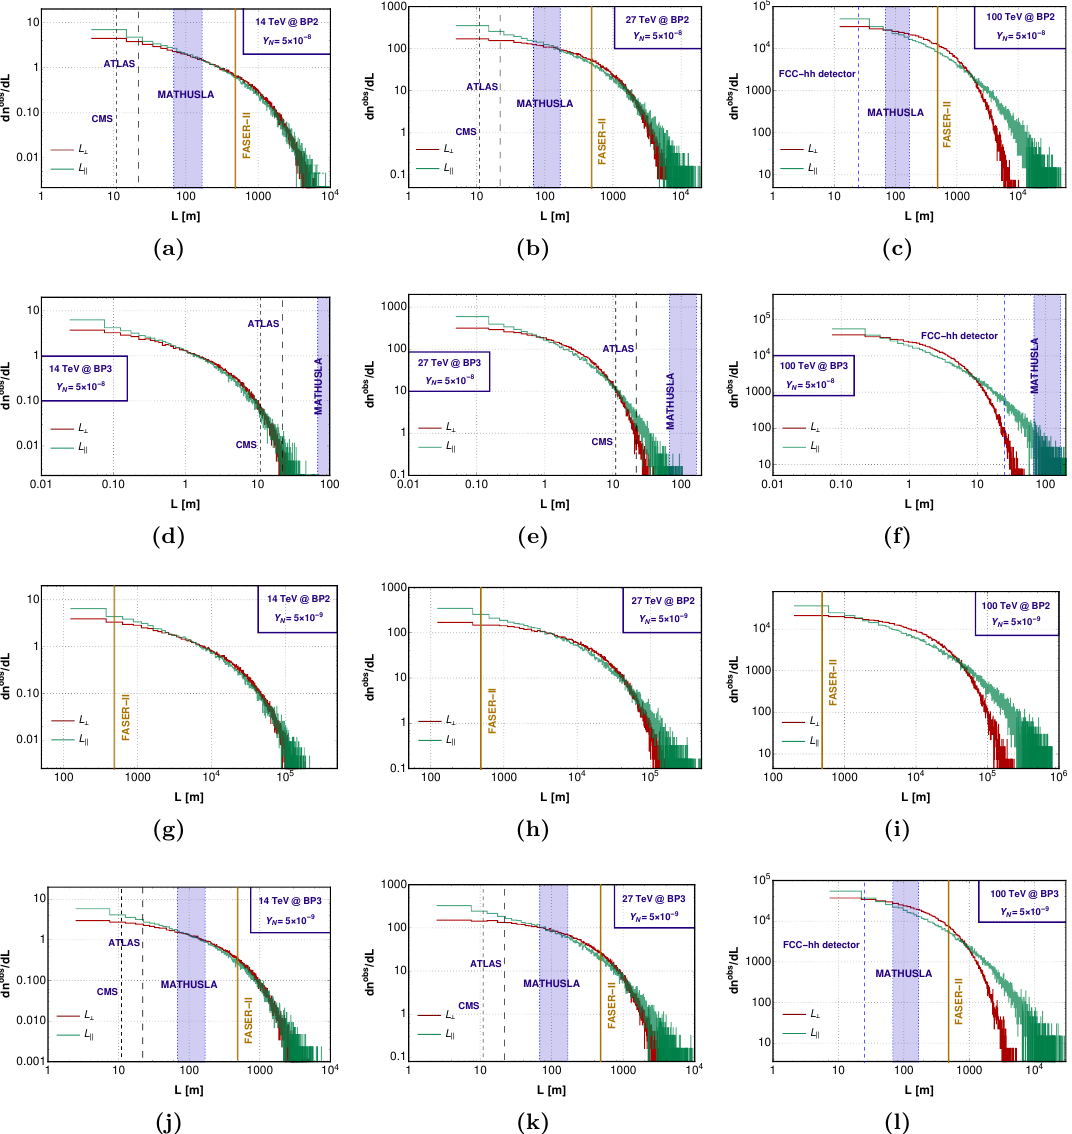
in green) decay length Figure 11. Displaced transverse ( L ⊥ in red) and longitudinal ( L || distributions for N , coming from the pair productions at the LHC with the centre of mass energies of 14 TeV (a, d, g, j), 27 TeV (b, e, h, k) and 100 TeV (c, f, i, l) with the integrated luminosities of 3, 10, 30 ab − 1 , respectively for BP2 (first, third rows) and BP3 (second, fourth rows). The choice of Yukawa couplings are Y = 5 × 10 − 8 (first, second rows) and Y = 5 × 10 − 9 (third, N N fourth rows). The small-dashed and medium-dashed lines indicate the upper limits of CMS and ATLAS, respectively, whereas, the blue dashed line specify the upper limit of the proposed FCC-hh detector. The light blue band (68 m − 168 m) denotes the MATHUSLA region and the golden yellow strip denotes the FASER-II